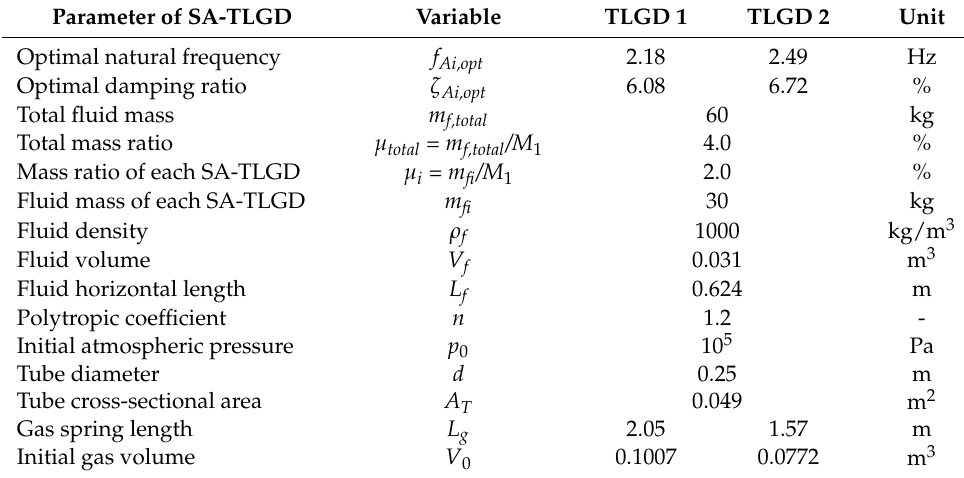
Table 3. Parameters and dimensions of the two optimized SA-TLGDs attached to the 3rd floor of the MDOF-shear frame